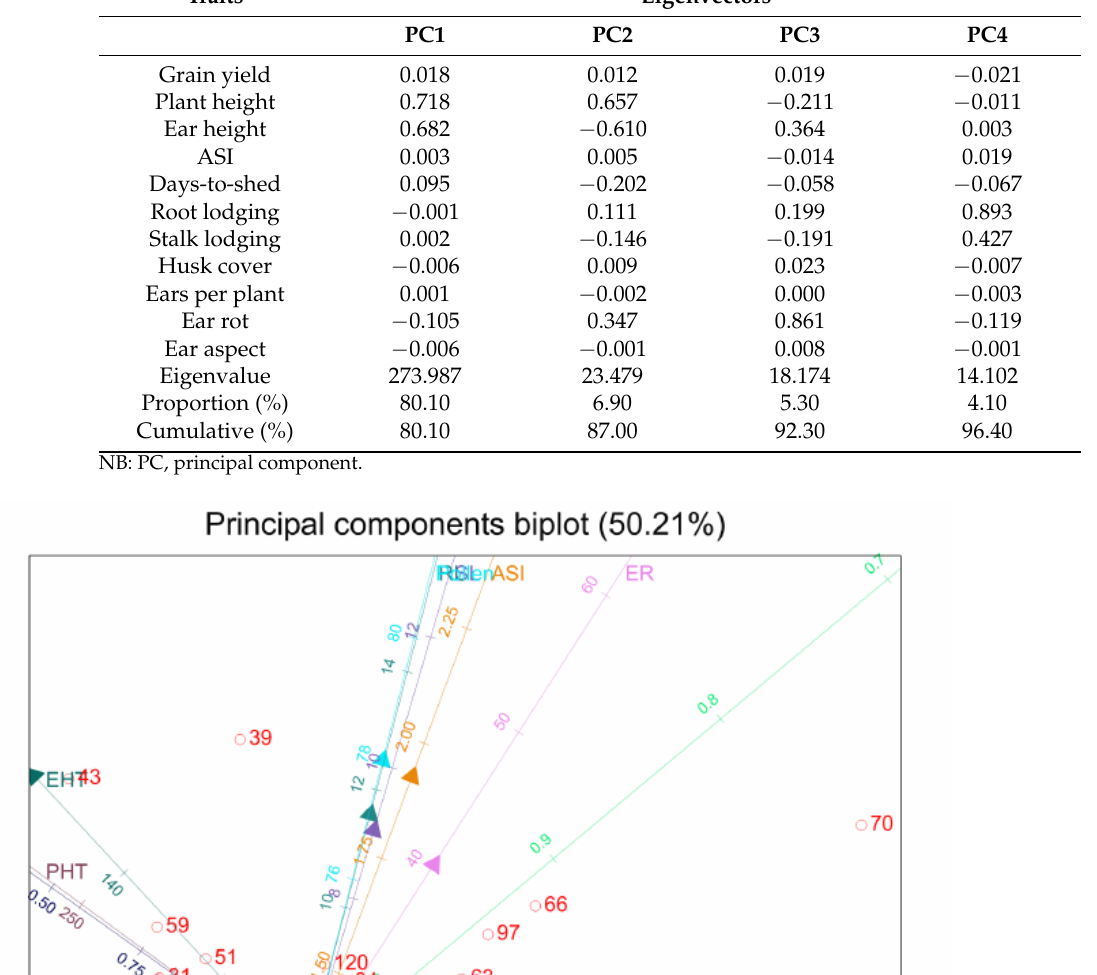
Table 2. Estimates of principal component analysis of maize hybrids for grain yield and agronomic traits. Traits